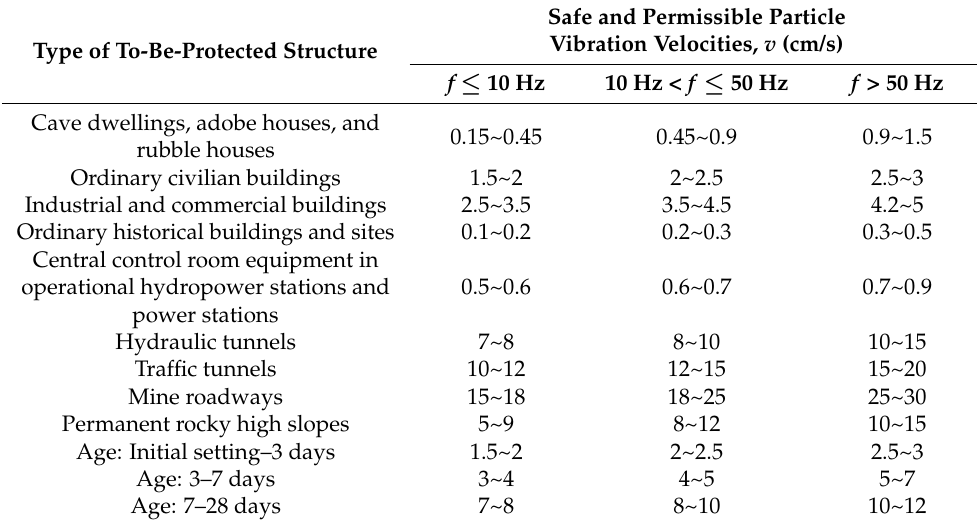
Table 6. Safety criterion for blast-induced vibrations